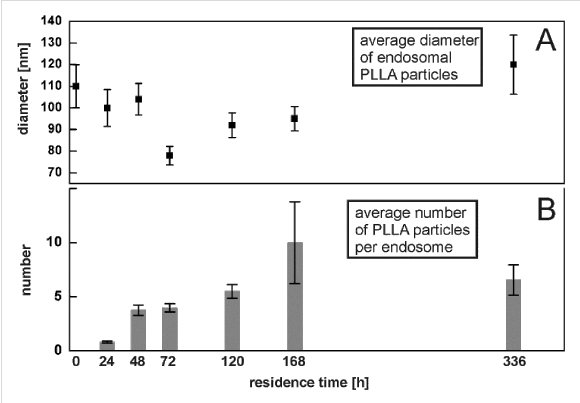
Figure 8: Quantitative evaluation of endosomal PLLA nanoparticles from TEM measurements. The average diameter of PLLA nanoparti- cles observed in HPF–freeze-substituted TEM samples (A). The first value at 0 h corresponds to the pristine PLLA nanoparticles. Number of PLLA nanoparticles averaged over the entity of all endosomes